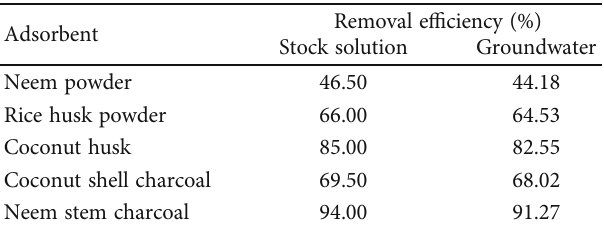
Table 2: Removal e ffi ciency comparison between stock solution and